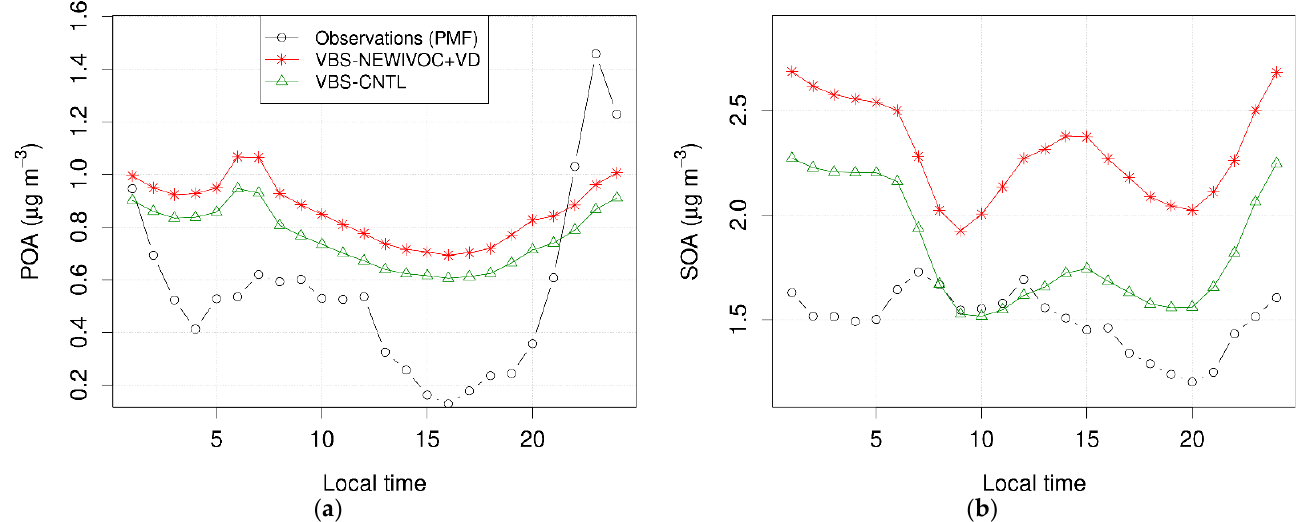
Figure 14. Mean diurnal profile of observed (PMF results, black) and modeled POA ( a ) and SOA ( b ) concentrations at the Bologna site for May 2013: VBS base simulation (VBS-CNTL, green) and VBS scheme with new parameterizations for IVOC emissions and revised volatility distribution (VBS-NEWIVOC+VD, red).